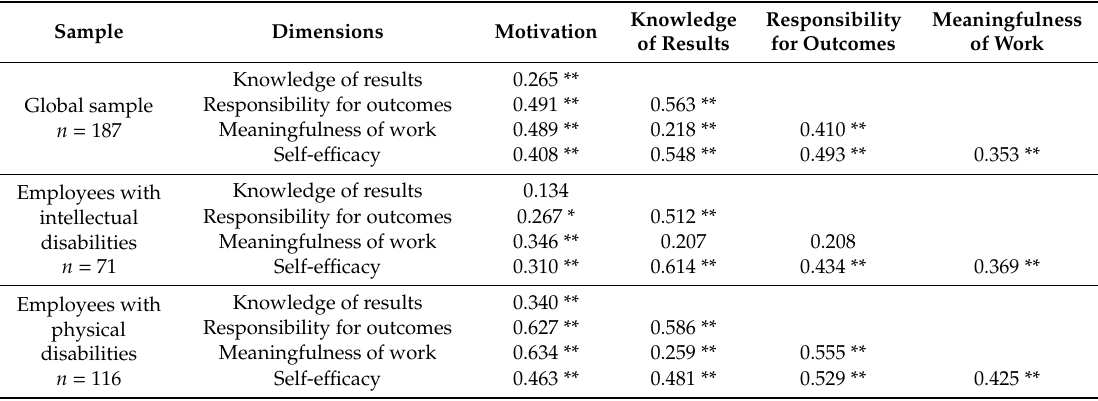
Table 3. Correlation coe ffi cients between variables.